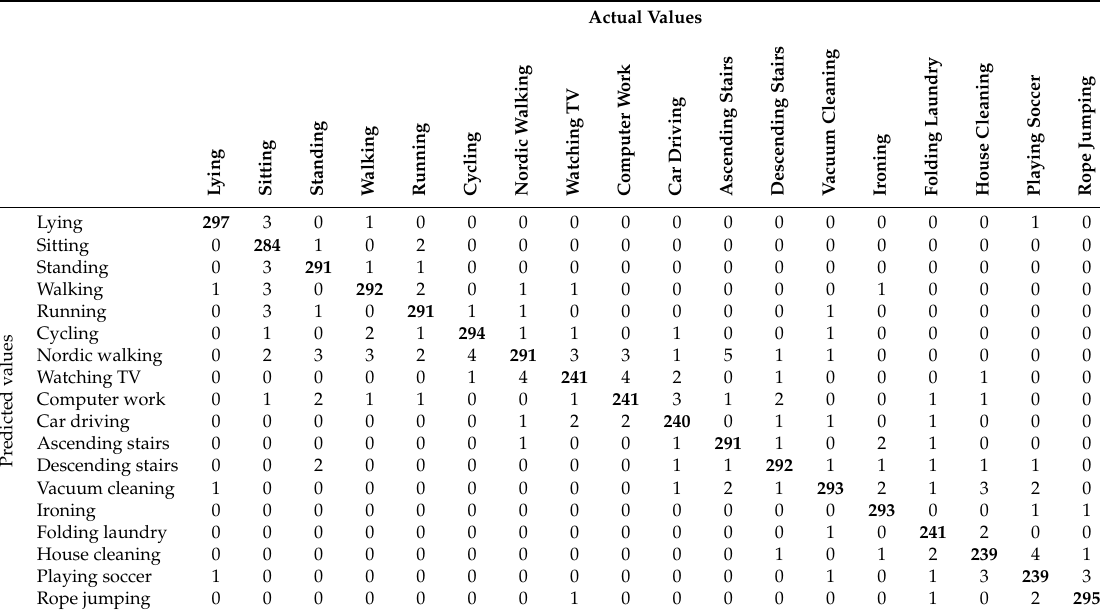
Table 15. Confusion matrix of the AHN classifier using the 7% noisy dataset.